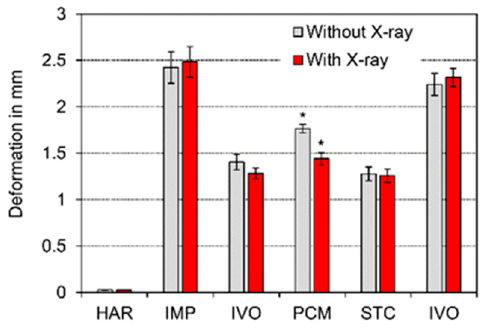
Figure 3. Flexural strength ( p < 0.05 → *).